Question: Name the type of graph shown.
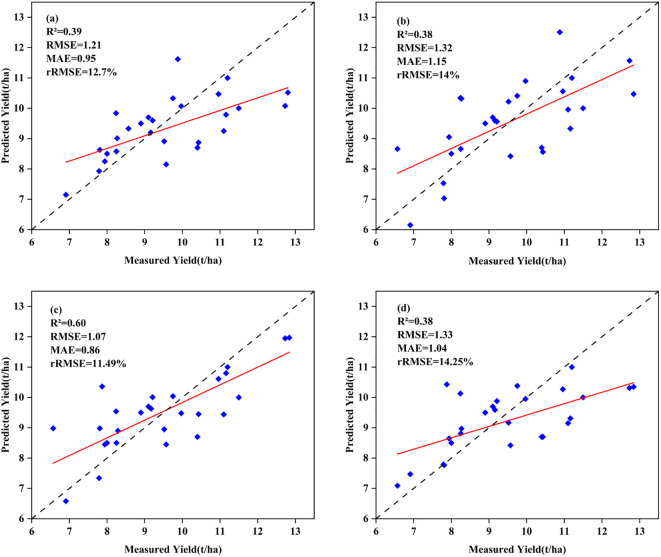
Answer: scatter